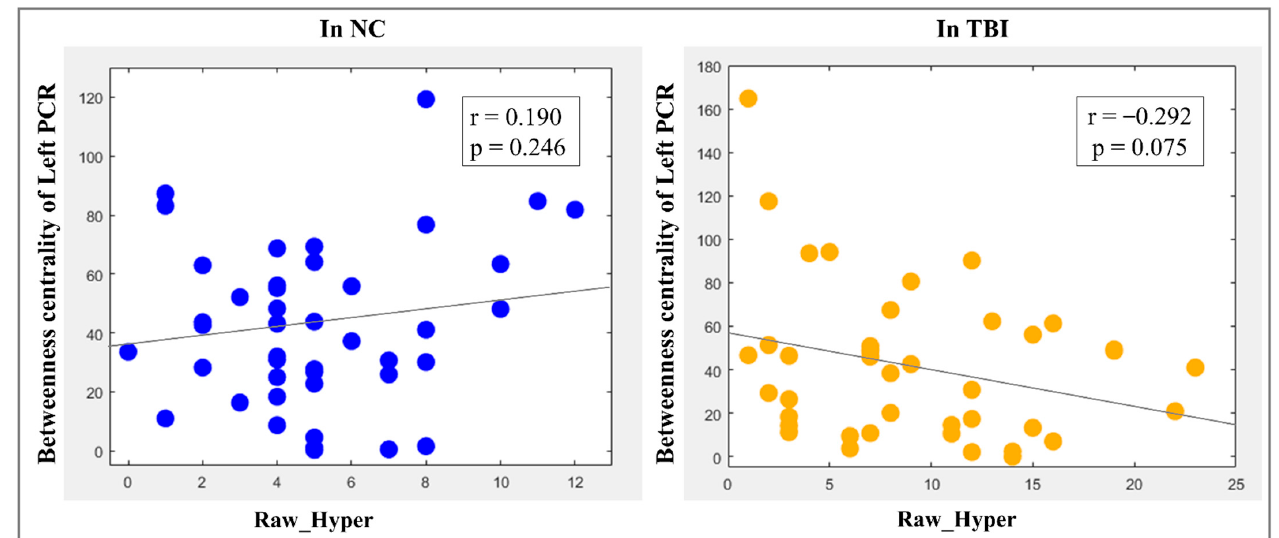
Figure 3. Brain–behavior relationships in the groups of NC and TBI. (NC: normal controls; TBI: traumatic brain injury; PCR: posterior corona radiata; Raw_Hyper: raw-scores of the Conner’s Adult ADHD Self-Reporting Rating Scales (CAARS) hyperactive symptoms; r: correlation coefficient; p : level of significance).